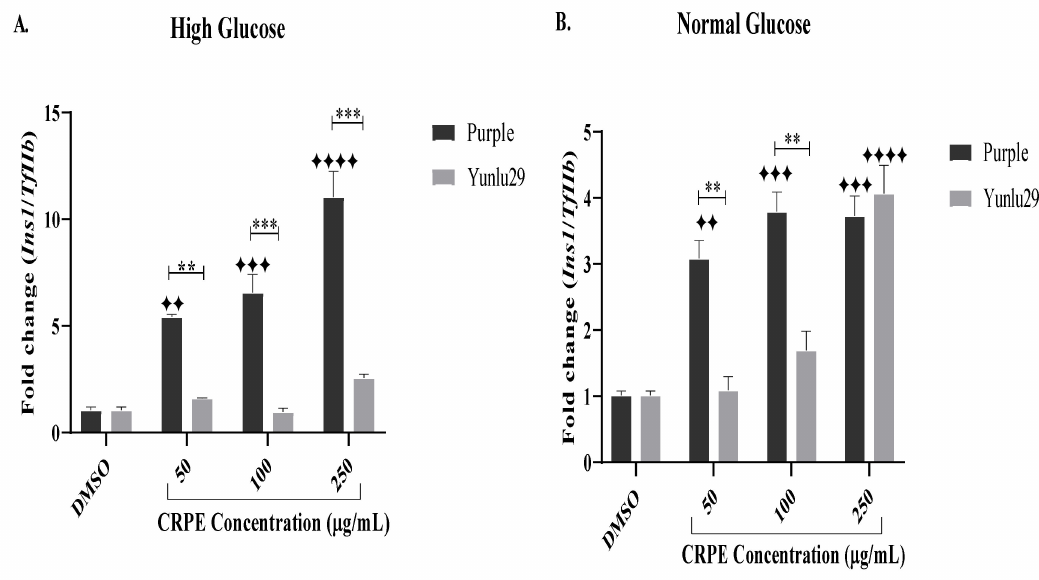
Figure 6. Expression of Ins1 gene on INS-1E cells. A ) high glucose (25 mM). B ) normal glucose (11.1 mM). n = 3. Stars indicate significant di ff erences between extracts and DMSO, where (cid:70)(cid:70) p < 0.01, (cid:70)(cid:70)(cid:70) p < 0.001, (cid:70)(cid:70)(cid:70)(cid:70) p < 0.0001. Asterisks indicate significant di ff erences between the extracts, where ** p < 0.01, *** p < 0.001; two-way ANOVA with Turkey’s multiple comparison post hoc test. Data is presented as mean ± SEM. Ins1—insulin 1; TfII β —transcription factor II β ; INS-1E—Insulinoma cells; DMSO—dimethyl sulfoxide; CRPE—coloured rice phenolic